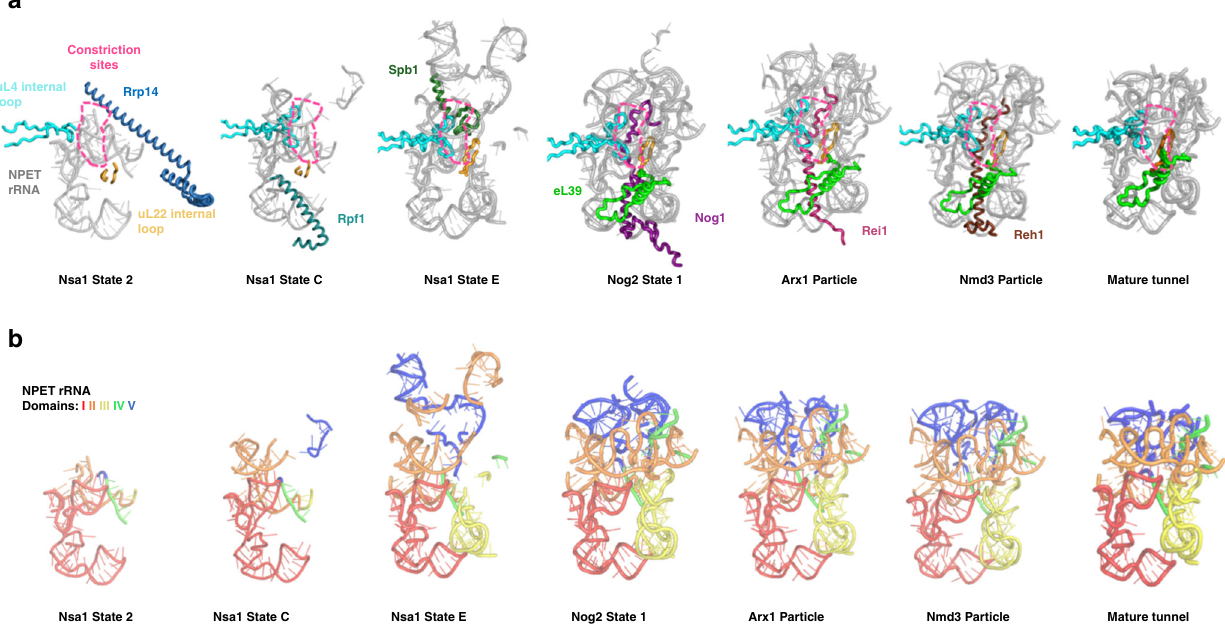
Fig. 1 Ordered stages of NPET assembly. a Cryo-EM structures of preribosomes revealed that the NPET undergoes distinct stages of assembly. The Nsa1 state 2 particle (PDB: 6C0F) contains Rrp14 (sky blue) associated with an NPET precursor. The uL4 (cyan) and uL22 (bright orange) internal loops can be seen but the tunnel domain (TD) of uL4 is not yet visible. The Nsa1 state C particle (PDB: 6EM1) displays Rpf1 (teal green) in an incomplete NPET. The TD of uL4 (cyan) is now visible at this stage. The Nsa1 state E particle (PDB: 6ELZ) contains a more complete NPET. The CTD of Spb1 (dark green) can be seen toward the entrance of the NPET. In Nog2 particles (PDB: 3JCT), a nearly mature NPET, now containing eL39 (green), can be visualized with the CTD of Nog1 (dark purple) stretching almost the entire length of the NPET. The Arx1 (PDB: 5APN) and Nmd3 (PDB: 5H4P) particles reveal no further NPET rRNA maturation but show that the CTDs of Rei1 (dark pink) and Reh1 (brown), respectively, now occupy the NPET. b Five domains of rRNA secondary structure make up the NPET. In Nsa1 state C, the NPET contains mostly domains I (red) and II (orange). A small portion of domain IV (green) can also be seen and domain V (blue) has not yet folded into the NPET. In Nsa1 state E, domain III (yellow) has folded into a stable conformation to join the NPET. In Nog2 state 1, domain V has stably folded into the NPET while a portion of domain II has also folded into a near mature state. Minor rearrangements in NPET rRNA can be observed in Arx1, Nmd3, and mature particles (PDB: 4V88). For clarity, only NPET-relevant portions of proteins and rRNA are